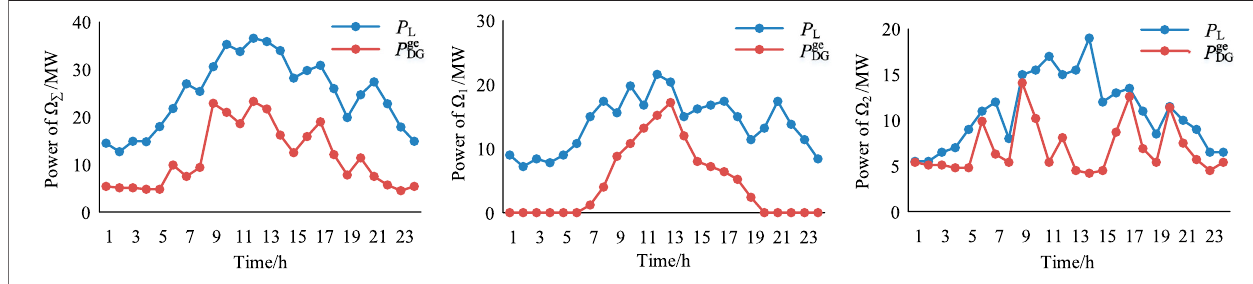
FIGURE 8 | Scenario 3: daily curve of the available output power of DGs and consumption power of the load.